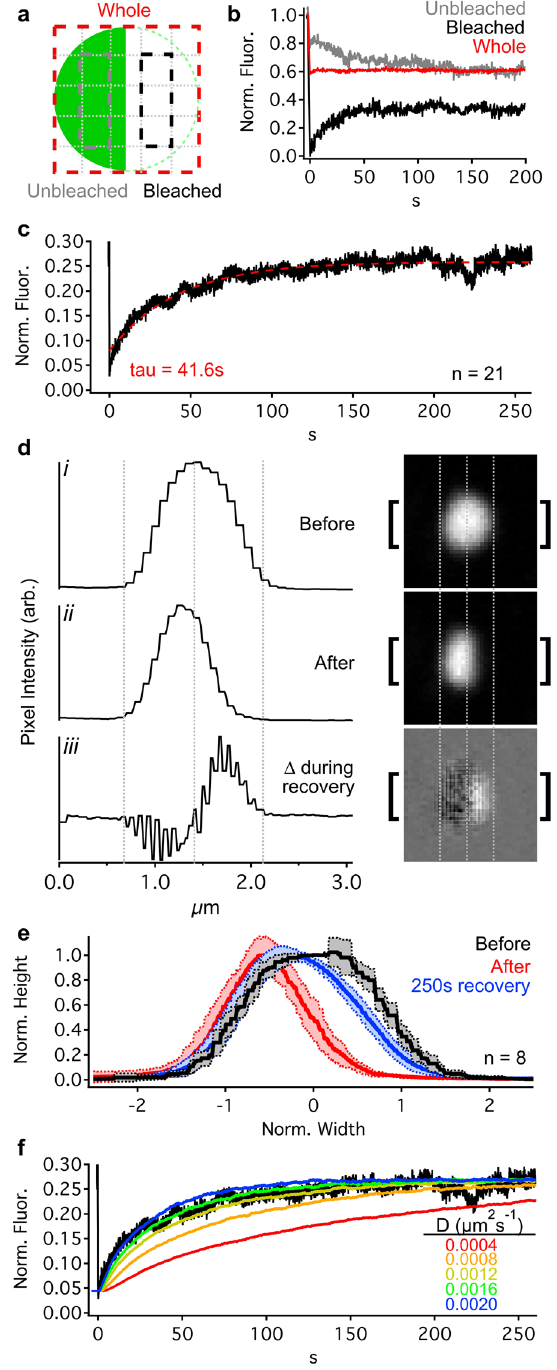
Figure 2. Ribeye is dynamic and mobile within the ribbon. ( a ) Ribbon schematic showing measurement regions: the whole ribbon (dashed red), within the bleached (dashed black) and unbleached (dashed gray) hemispheres. ( b ) Normalized fluorescence profiles for each region in a following bleaching of half the ribbon (at 0 s) for an example ribbon (same as in d). ( c ) Average normalized recovery curve for bleached hemisphere (n = 21 ribbons; red: exponential fit). ( d ) Pixel intensity profiles (left) from regions between brackets in images (right) before (i) and after (ii) bleaching. The bottom profile and image (iii) show the average change in pixel intensity for each pixel over successive images during the first 50 time points (~17 s) of recovery. Gray indicates no average change, while brighter and darker values indicate gain and loss of fluorescence, respectively. ( e ) Pixel intensity profiles (mean ± SD, n = 8 ribbons) across the center of ribbons before (black), immediately after (red), and 250 s after (blue) bleaching. Ribbons diameters were normalized to the same width; the peaks of pixel intensities were normalized. ( f ) Average recovery of the bleached hemisphere (from c) compared to particle simulations with different diffusion coefficients (colored traces). Each simulation trace is an average of 20 runs. See also Supplementary Fig. S2, Supplementary Movie